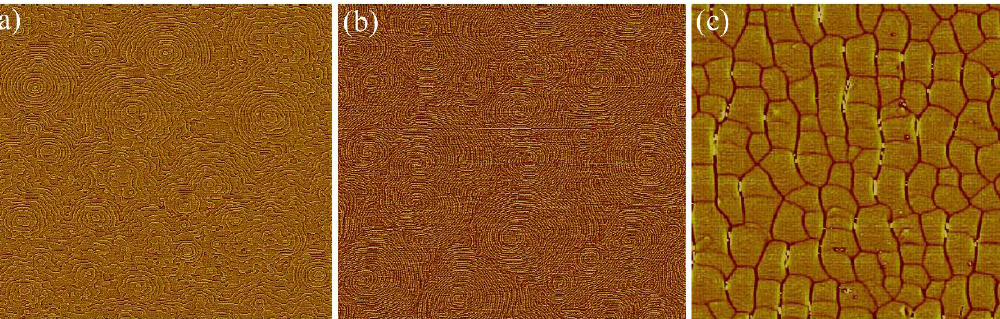
Figure 3. AFM top view (10 μm × 10 μm) of a 2D surface for #001 GaSb substrate ( a ), 2D-T mode for #003 homoepitaxial ( b ), and 3D mode for #009 metamorphic ( c ) GaSb samples.